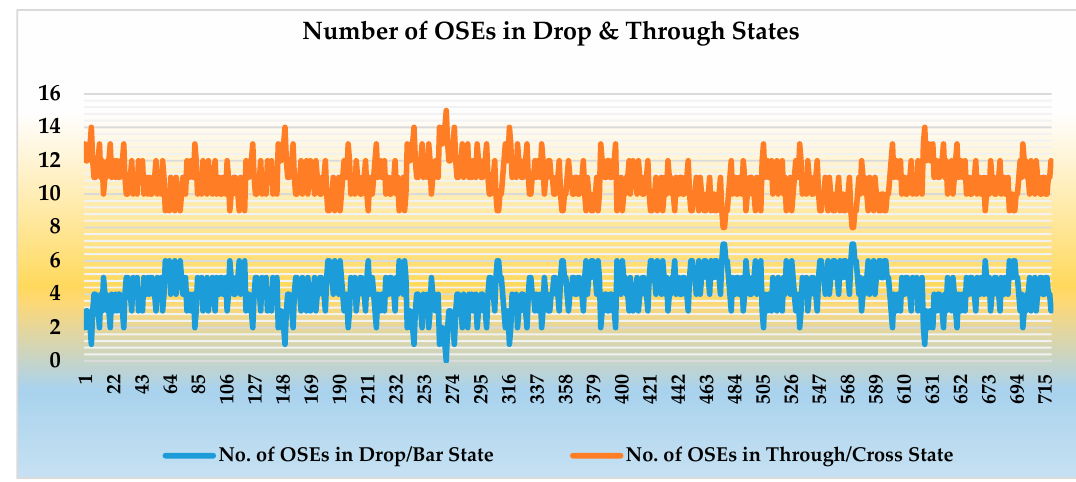
Figure 8. Number of OSEs in drop/bar and through/cross states in optimal switching combinations for un-optimized HCROS. Table 7. Analysis of optimal switching combinations in optimized